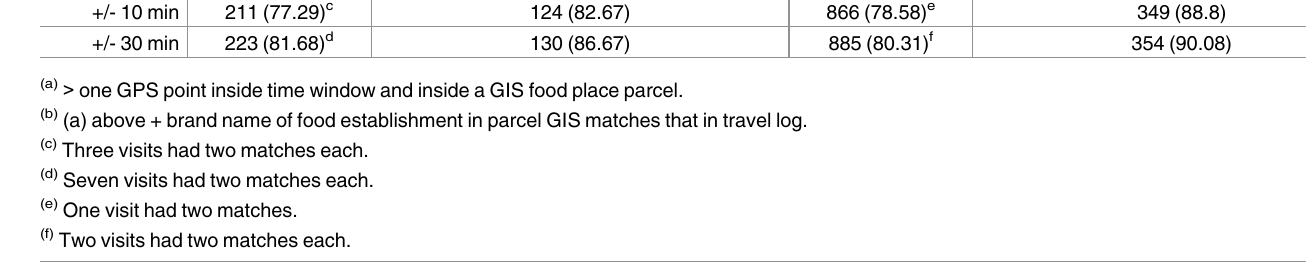
which was 7.4 minutes shorter than the mean GPS duration for the same visit. For the +/- 10 minute and +/-30 minute tolerances, the mean reported durations were 3.37 and 1.95 minutes shorter, respectively. For GPS—sensed visits, the correlation between the GPS-measured duration and the reported duration of fast food visits ranged from 0.97 (p < 0.001) at the exact time window, to 0.95 (p < 0.001) and 0.91 (p < 0.001) at the +/- 10 minute and +/- 30 minute tolerances (Table 3). For supermarket visits the correlations were smaller; 0.77 (p < 0.001), 0.76 (p < 0.001), and 0.75 (p < 0.001) at the exact time, the +/- 10 minute tolerance, and the +/- 30 min- ute tolerance, respectively (Table 3).